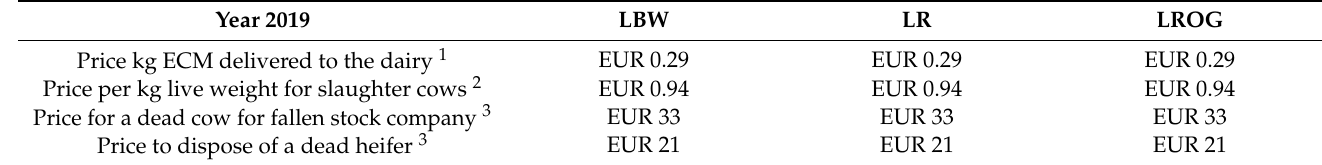
Table 6. Levels of prices and costs (in Euro) used for